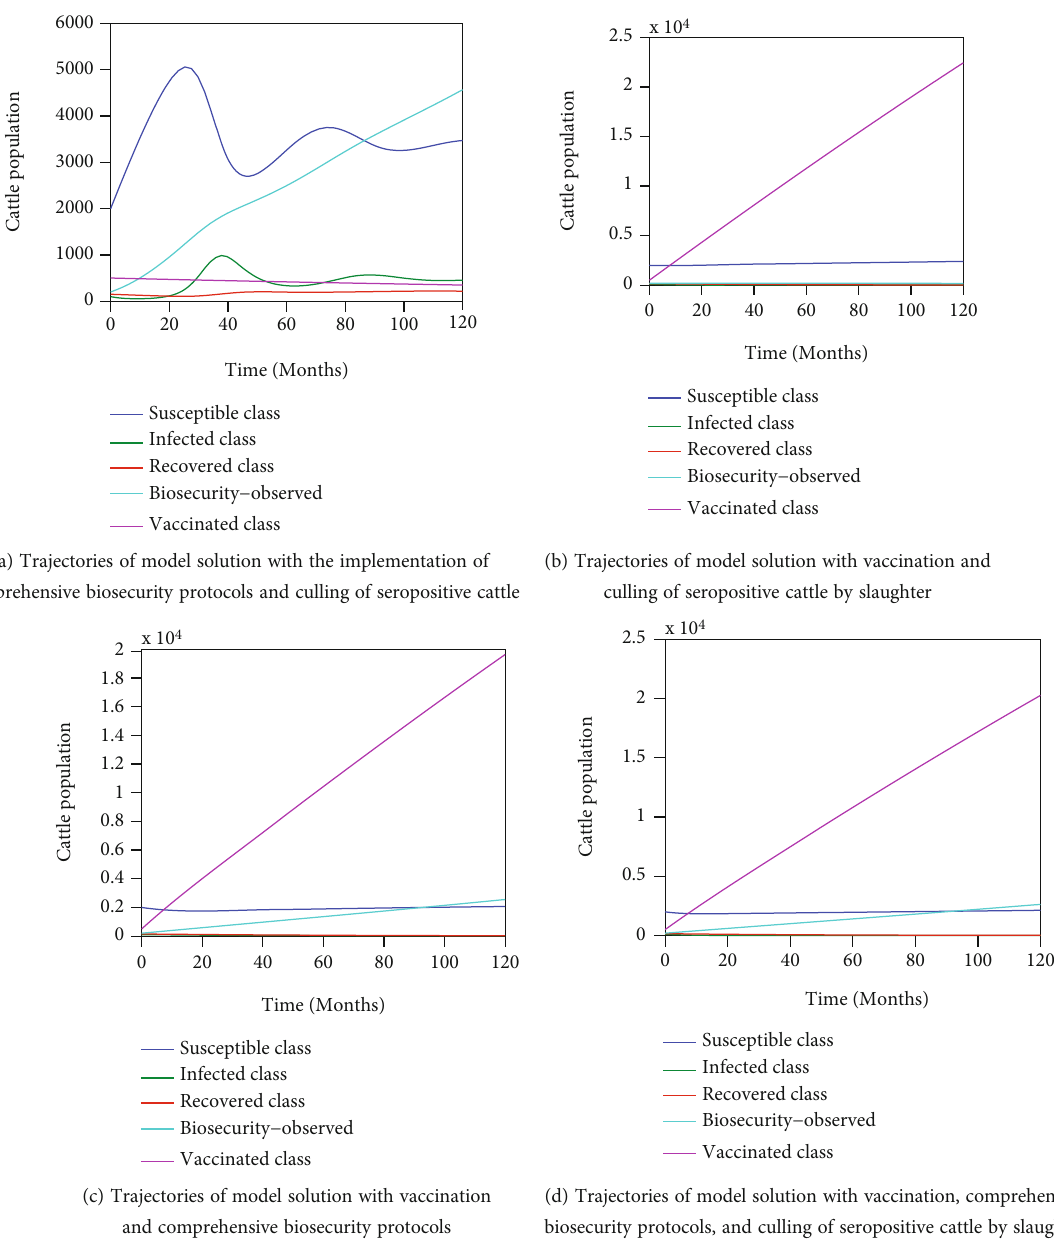
Figure 3: Trajectories of model solutions with various combination of control